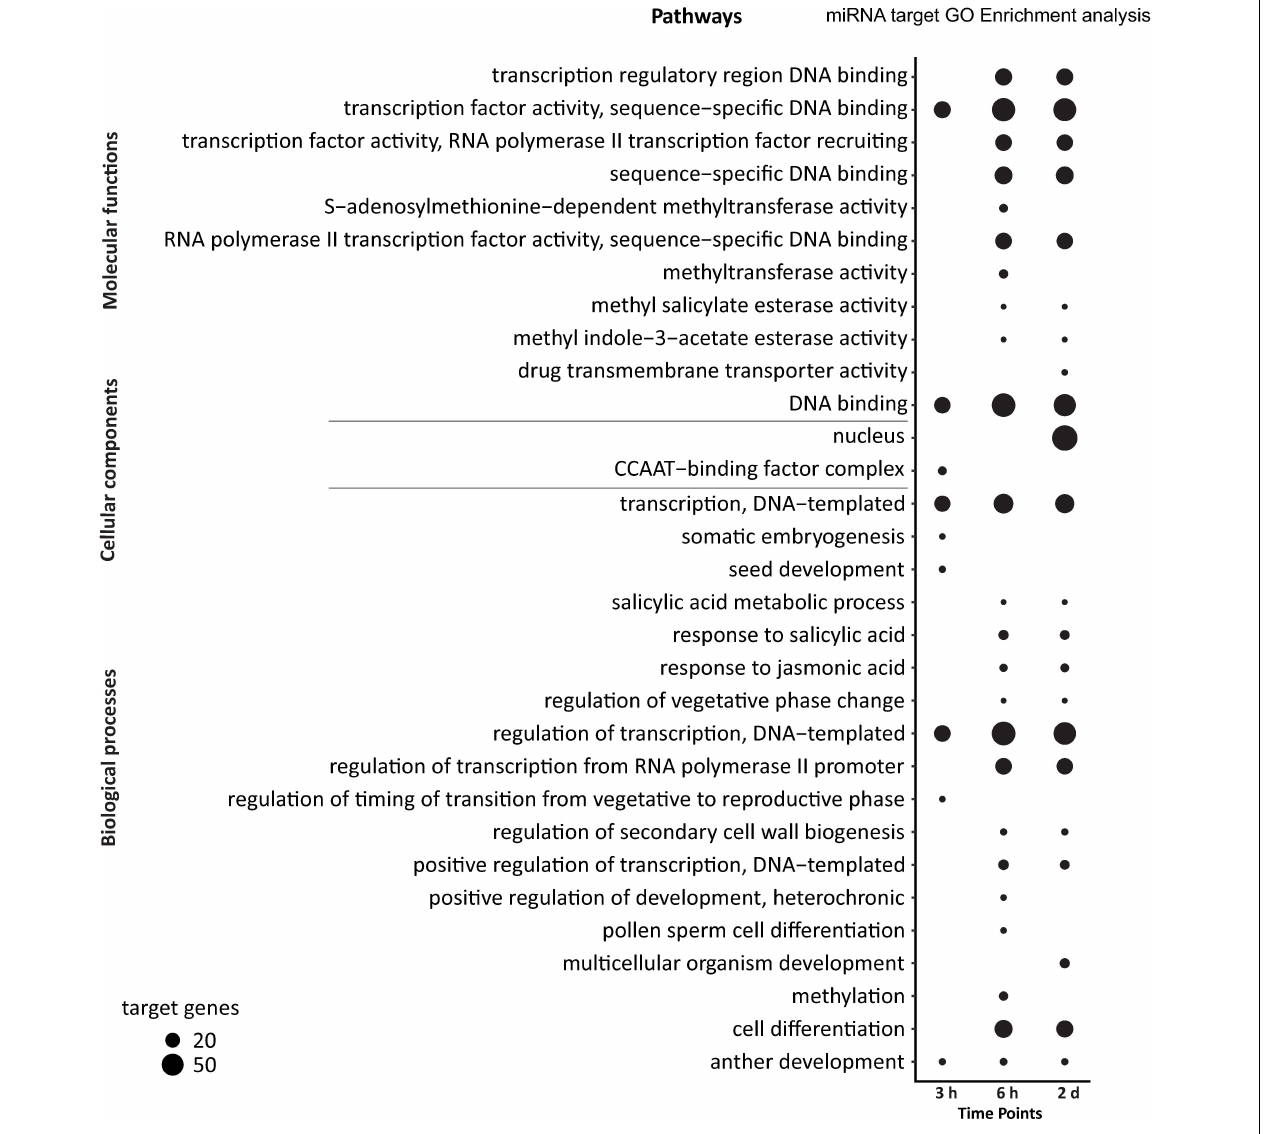
FIGURE 4 | Gene ontology analysis for all predicted targets of DE miRNAs in high light acclimation. The dot plot represents GO terms categorized into molecular functions, cellular components and biological processes. The GO terms and the time points of the high light treatment were depicted on the y - and x -axis, respectively. The bubble size represents the number of genes in that particular GO term (Benjamini-Hochberg corrected p -value ≤